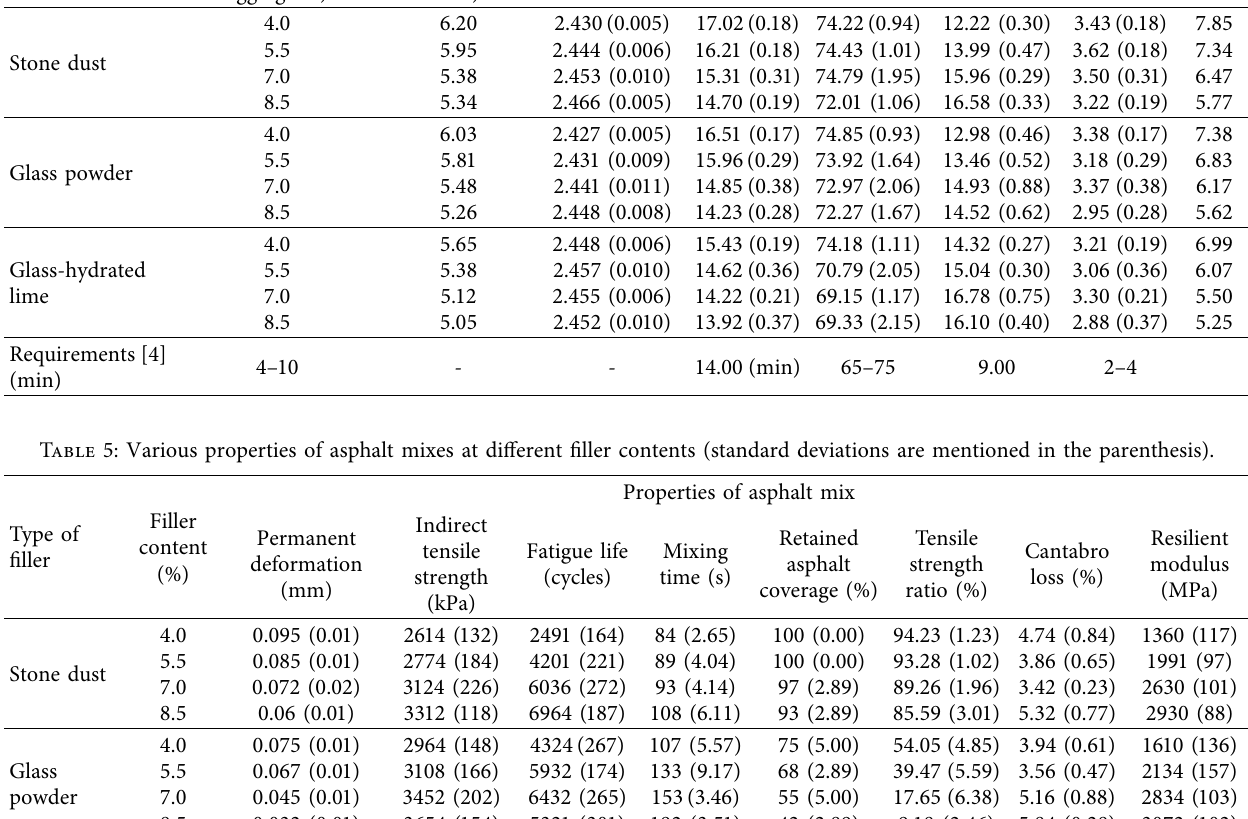
Table 4: Marshall and volumetric properties of various mixes (standard deviations are mentioned in the parenthesis). Type of filler